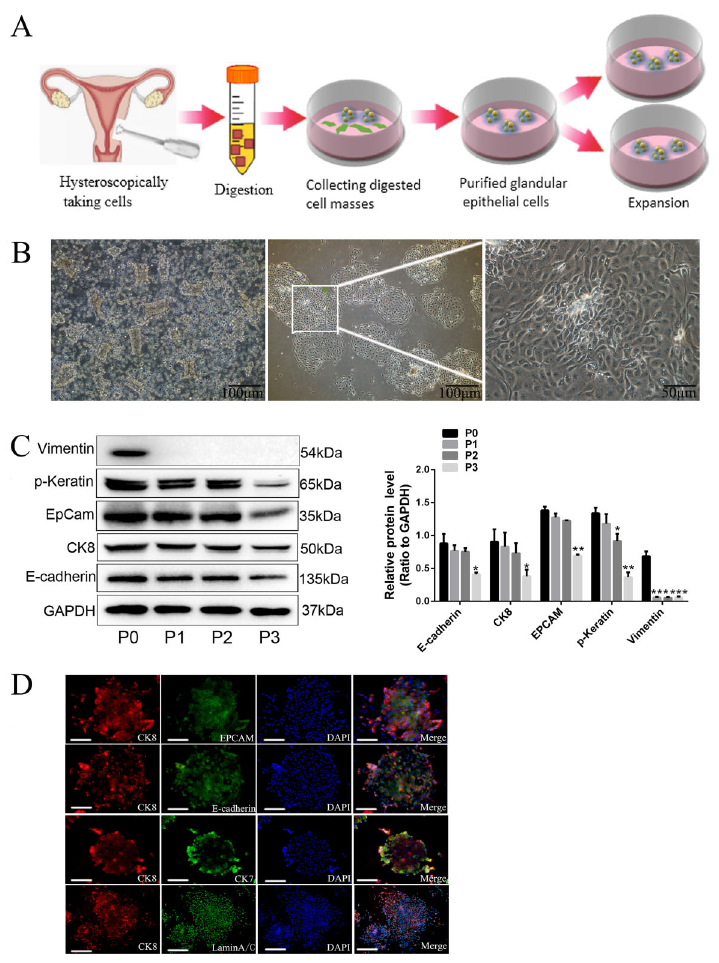
Figure 1. Cultivation and characterization of human endometrial epithelial cells (hEECs). A , Diagram showing the procedure of hEECs isolation and expansion. B , The left panel shows hEECs without adherence (scale bar 100 m m); the middle and right panels show images of attached hEECs at different magni fi cations after 24 h (scale bars 100 and 50 m m). C , Western blotting showing the protein levels of endometrial epithelial markers in P0 to P3 generations. D , Anti-CK8, anti-epithelial cell adhesion molecule (EPCAM),